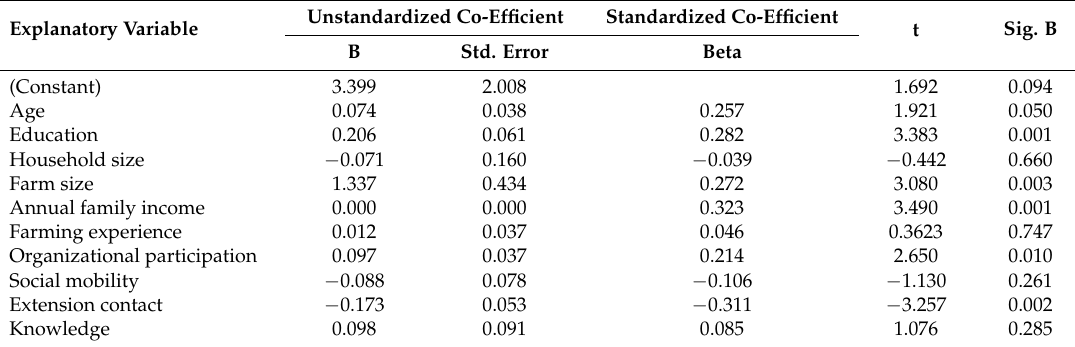
Table 5. Summary of multiple linear regression explaining the focus variable ( n = 100). Explanatory